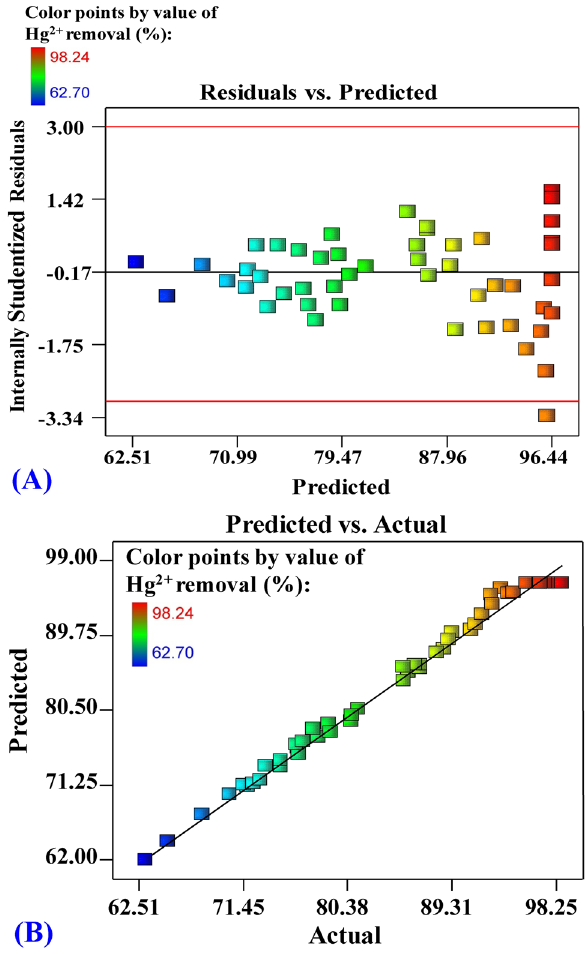
Figure 5. ( A ) Plot of internally studentized residuals versus predicted values, and ( B ) plot of predicted versus actual values of biosorption of Hg 2+ by Gelidium corneum